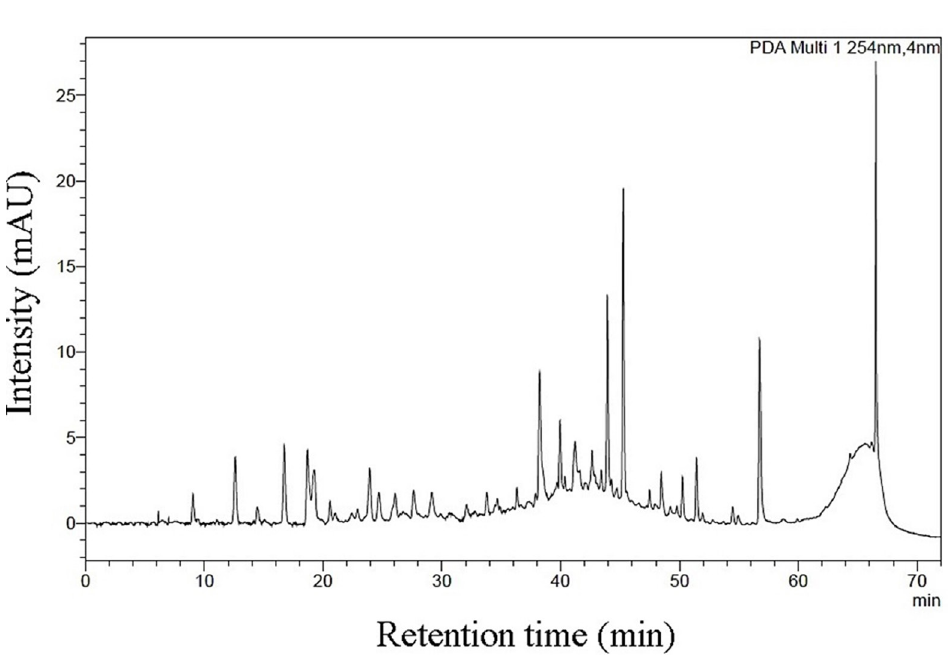
FIGURE 2 - Chromatographic profile of the ethyl acetate phase of the aerial parts of Cyperus articulatus L. (EAFCAAP) at 254 nm